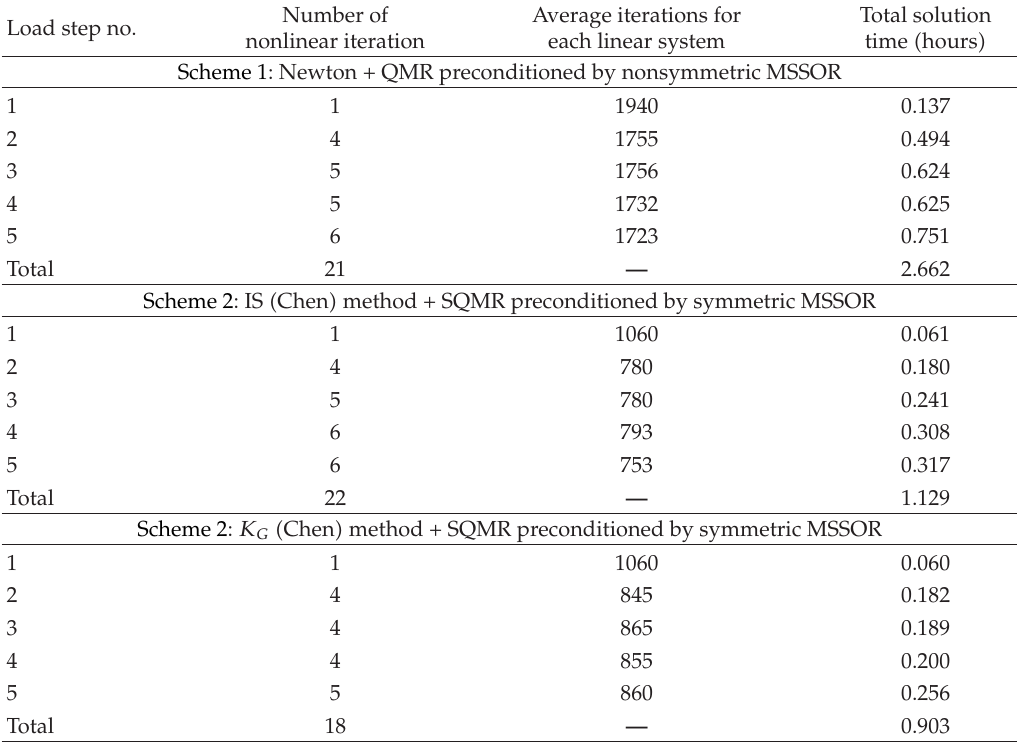
Table 2: Performance of di ff erent solution schemes for the flexible footing